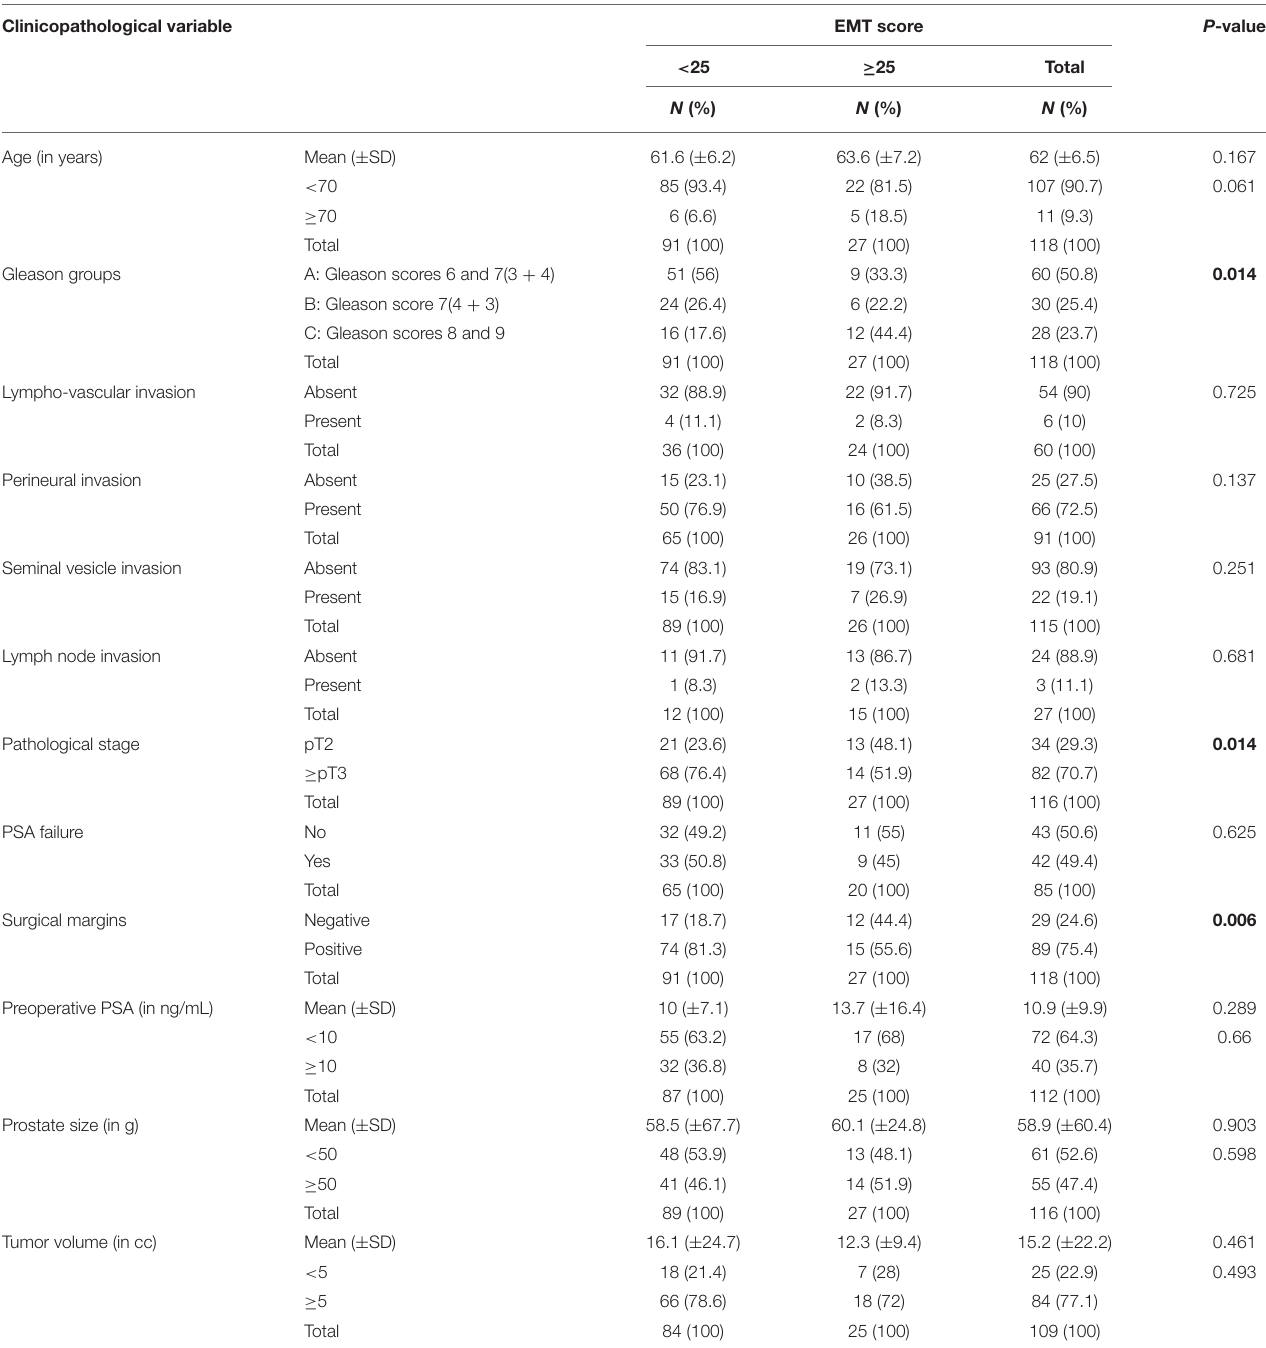
TABLE 2 | Correlation of EMT score with the patients’ clinicopathological variables. Clinicopathological